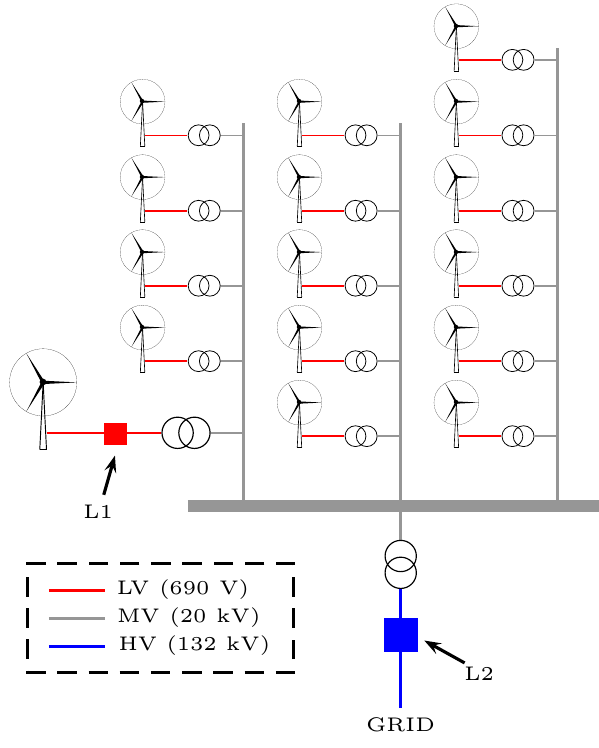
Figure 3. Illustration of the electrical layout of the